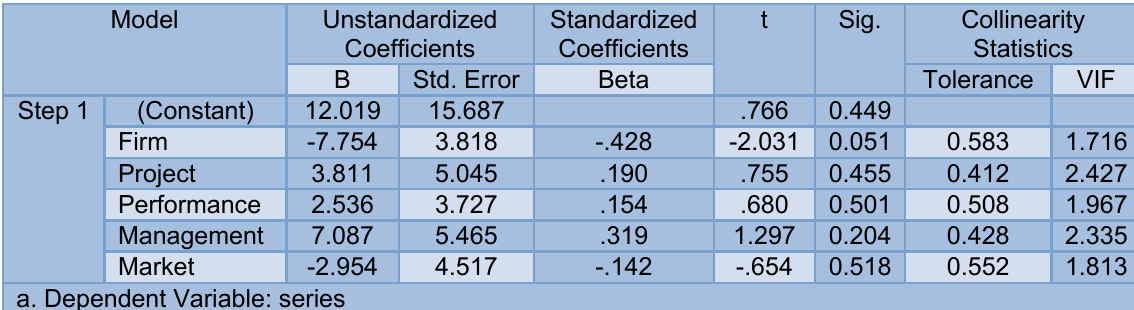
Table 7: Coefficientsa and collinearity statistics for ET Decision